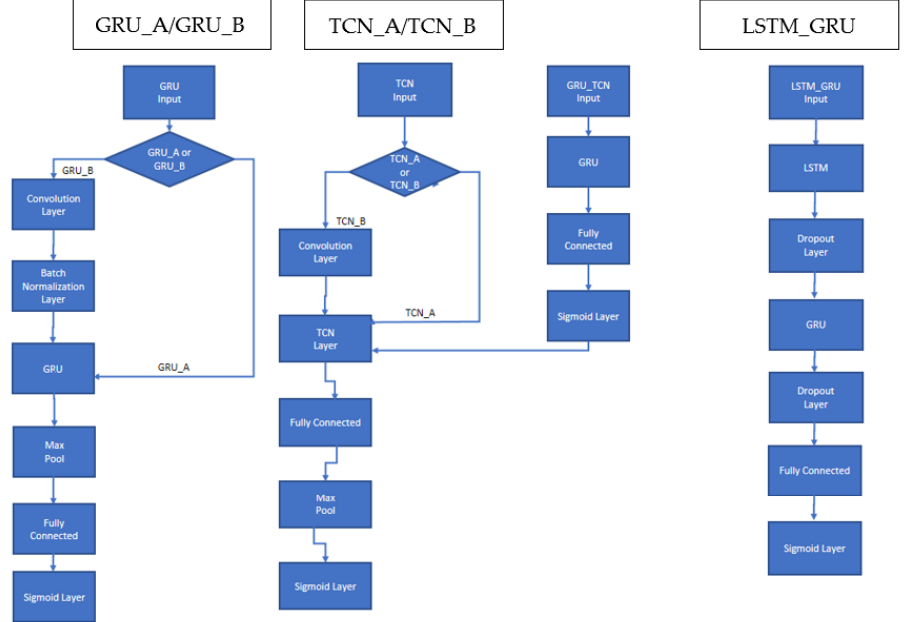
Figure 1. Schema of the proposed recurrent DNNs: GRU_A; TCN_A; GRU_B, TCN_B; LSTM_GRU.